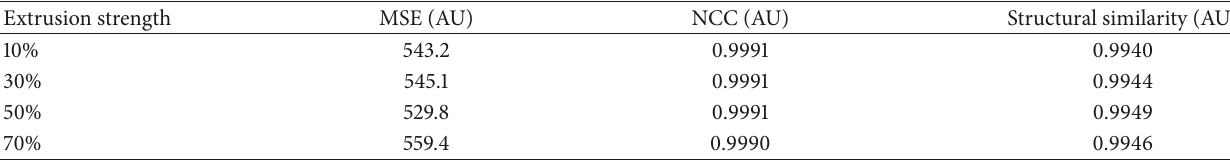
Table 3: Evaluation of registration result (extrusion deformation).